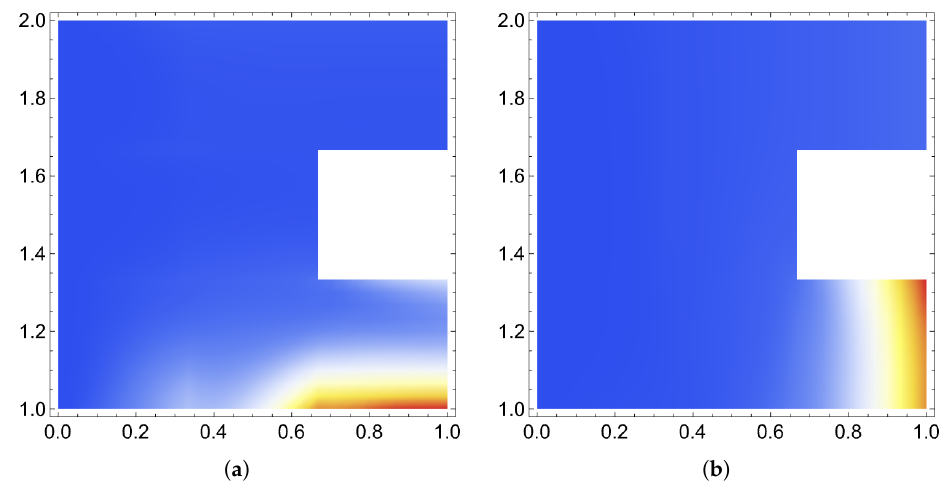
Figure 10. Eight regions of uncertain materials. Unit traction force acting on u 2 along the horizontal segment at y = 4/3. Temperature scale with zero level at the boundary x = 0. ( a ) Var ( u 1 ) ∈ [ 0,0.78 ] and ( b ) Var ( u 2 ) ∈ [ 0,5.40 ] . Decay rates: ζ i = 2, ε i = 1/10, i = 1, . . . ,8.